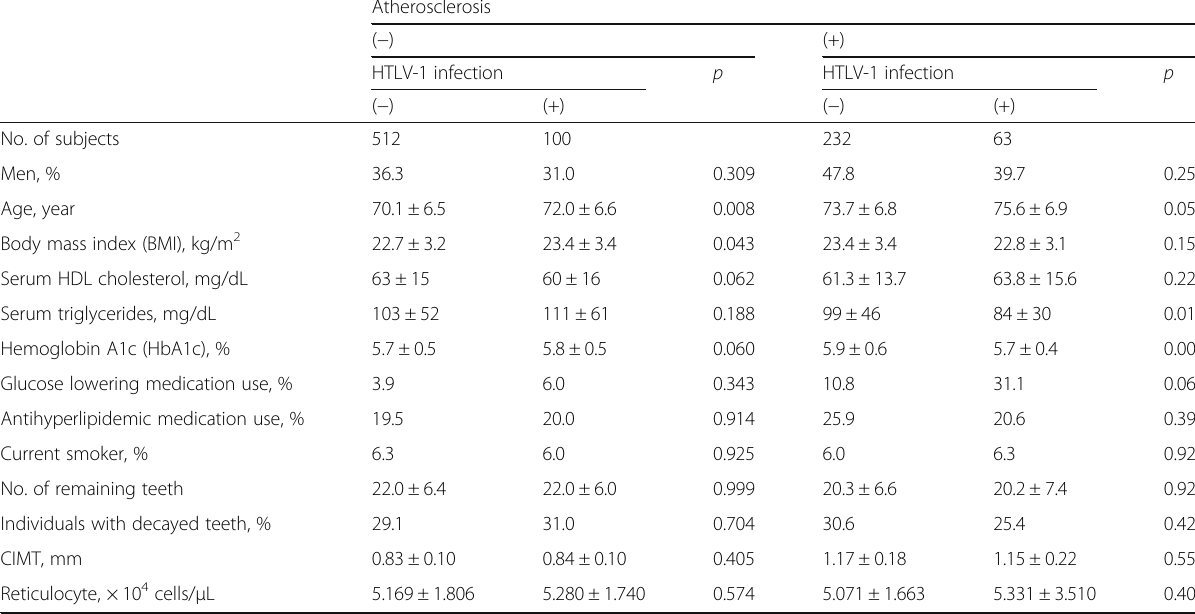
Table 1 Characteristics of the study population